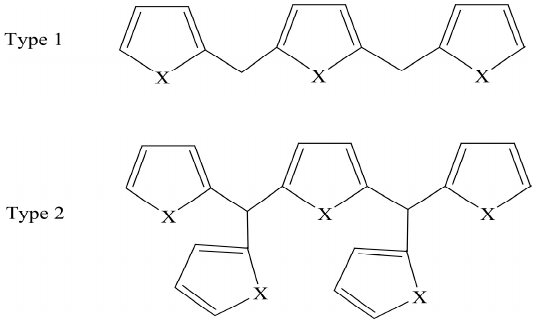
Figure 1. Proposed structures for melanoidin polymers, X = NR or O [12].